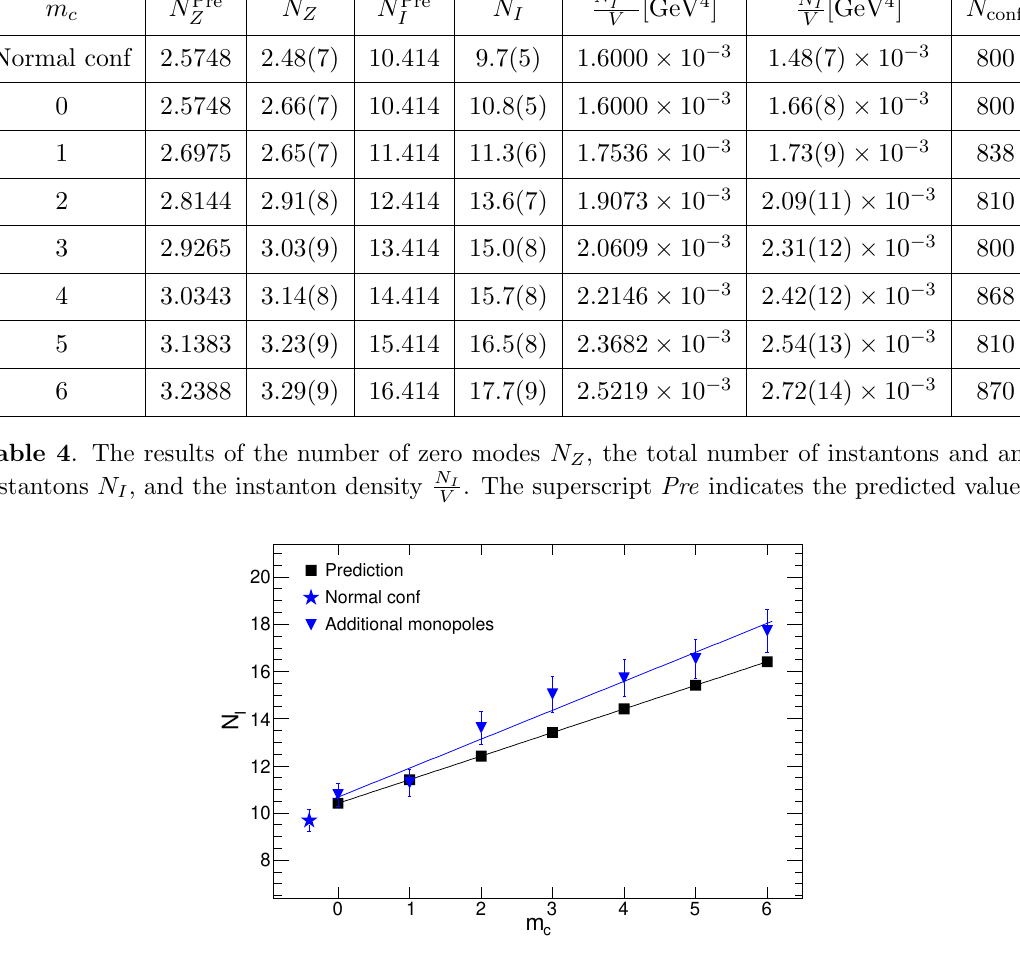
Figure 3 . The total number of instantons and anti-instantons N I versus the magnetic charges m c . The blue and black lines indicate the (cid:12)tting